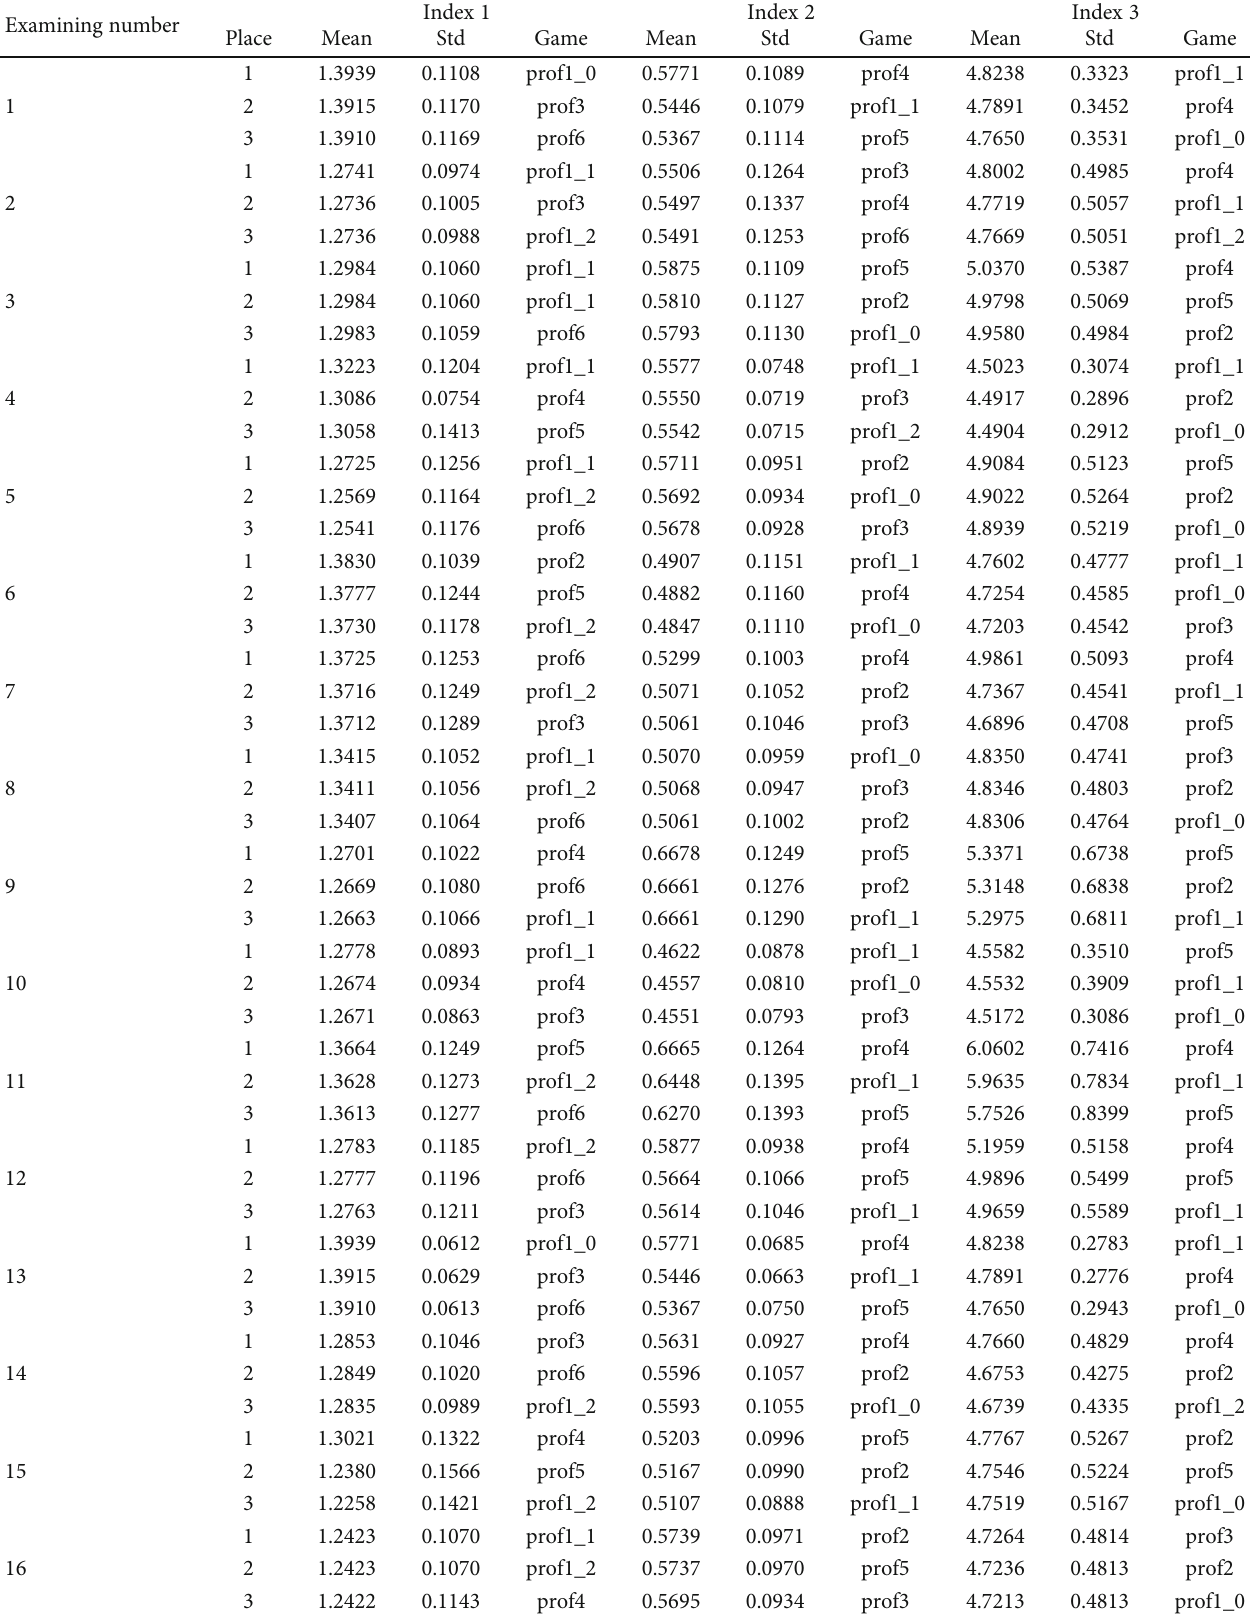
Table 5: The table shows at which game the engagement index was